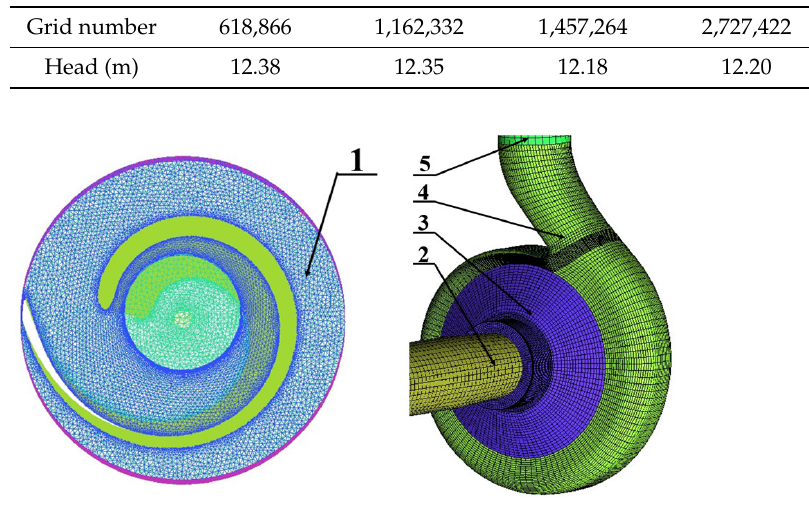
Figure 1. Model pump. ( a ) Calculation domains. ( b ) Cross-section of the pump model. 1. Inlet, 2. Impeller, 3. Chamber, 4. Volute, 5. Outlet. Table 1. Head of the pump at different grid number.